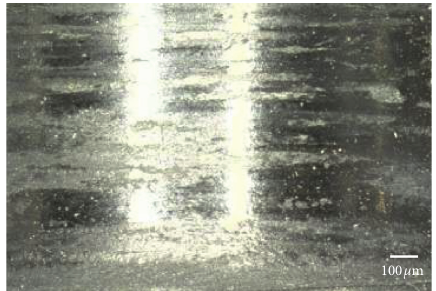
Figure 26: The whole morphology of the